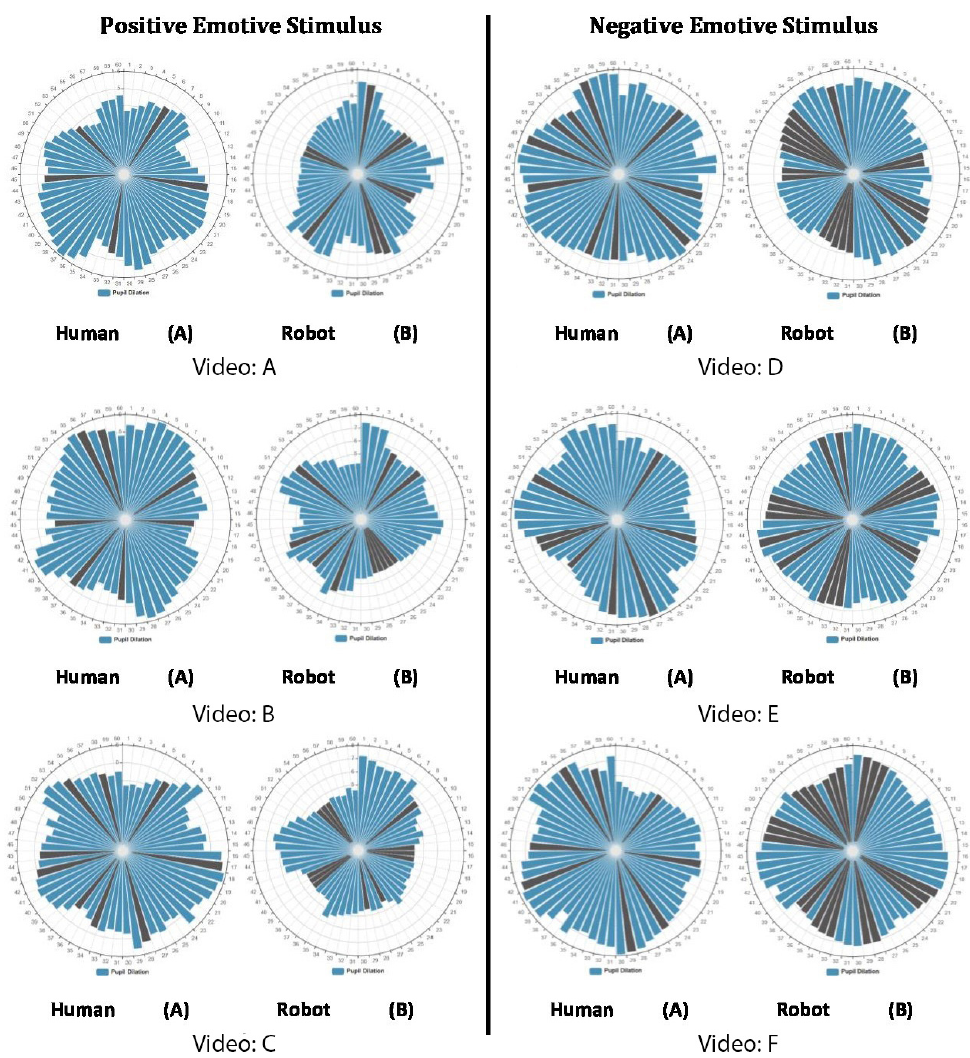
Figure 11. Human and Robot Pupil Dilation to Positive and Negative Emotional Video Stimulus for 60 s. The black lines indicate reconstructed data fields. Hyperlinks to the videos are available in the GitHub repository github.com/carlstrath/Robotic_Eye_System (accessed 22 September 21) Although the head-mounted LUX meter indicated that ambient lighting was stable and proximal during the positive and negative video-based stimulus (304–342 lux), the